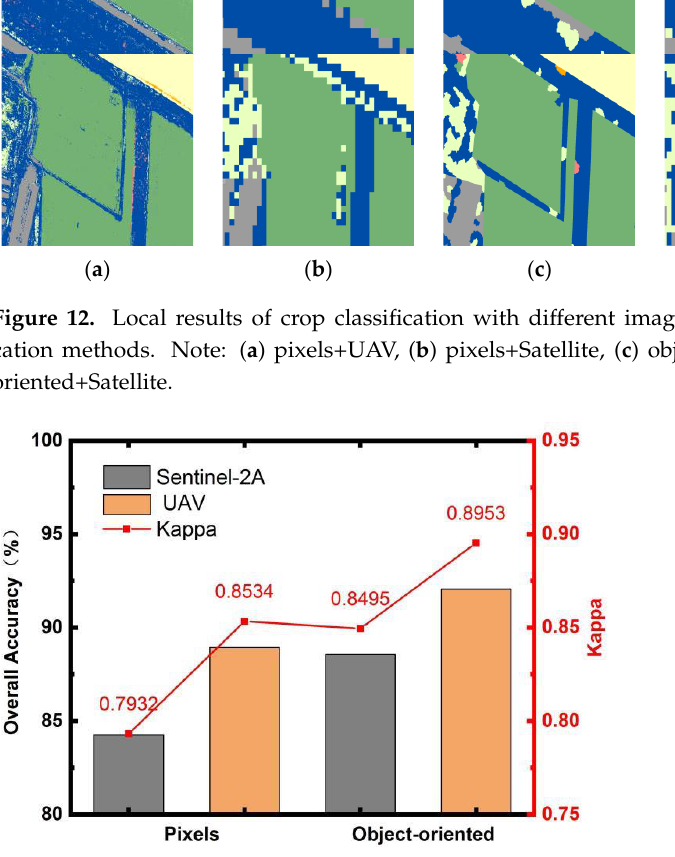
Table 4. Results of crop classification accuracy of remote sensing images with different time resolu- tions. Schemes Name